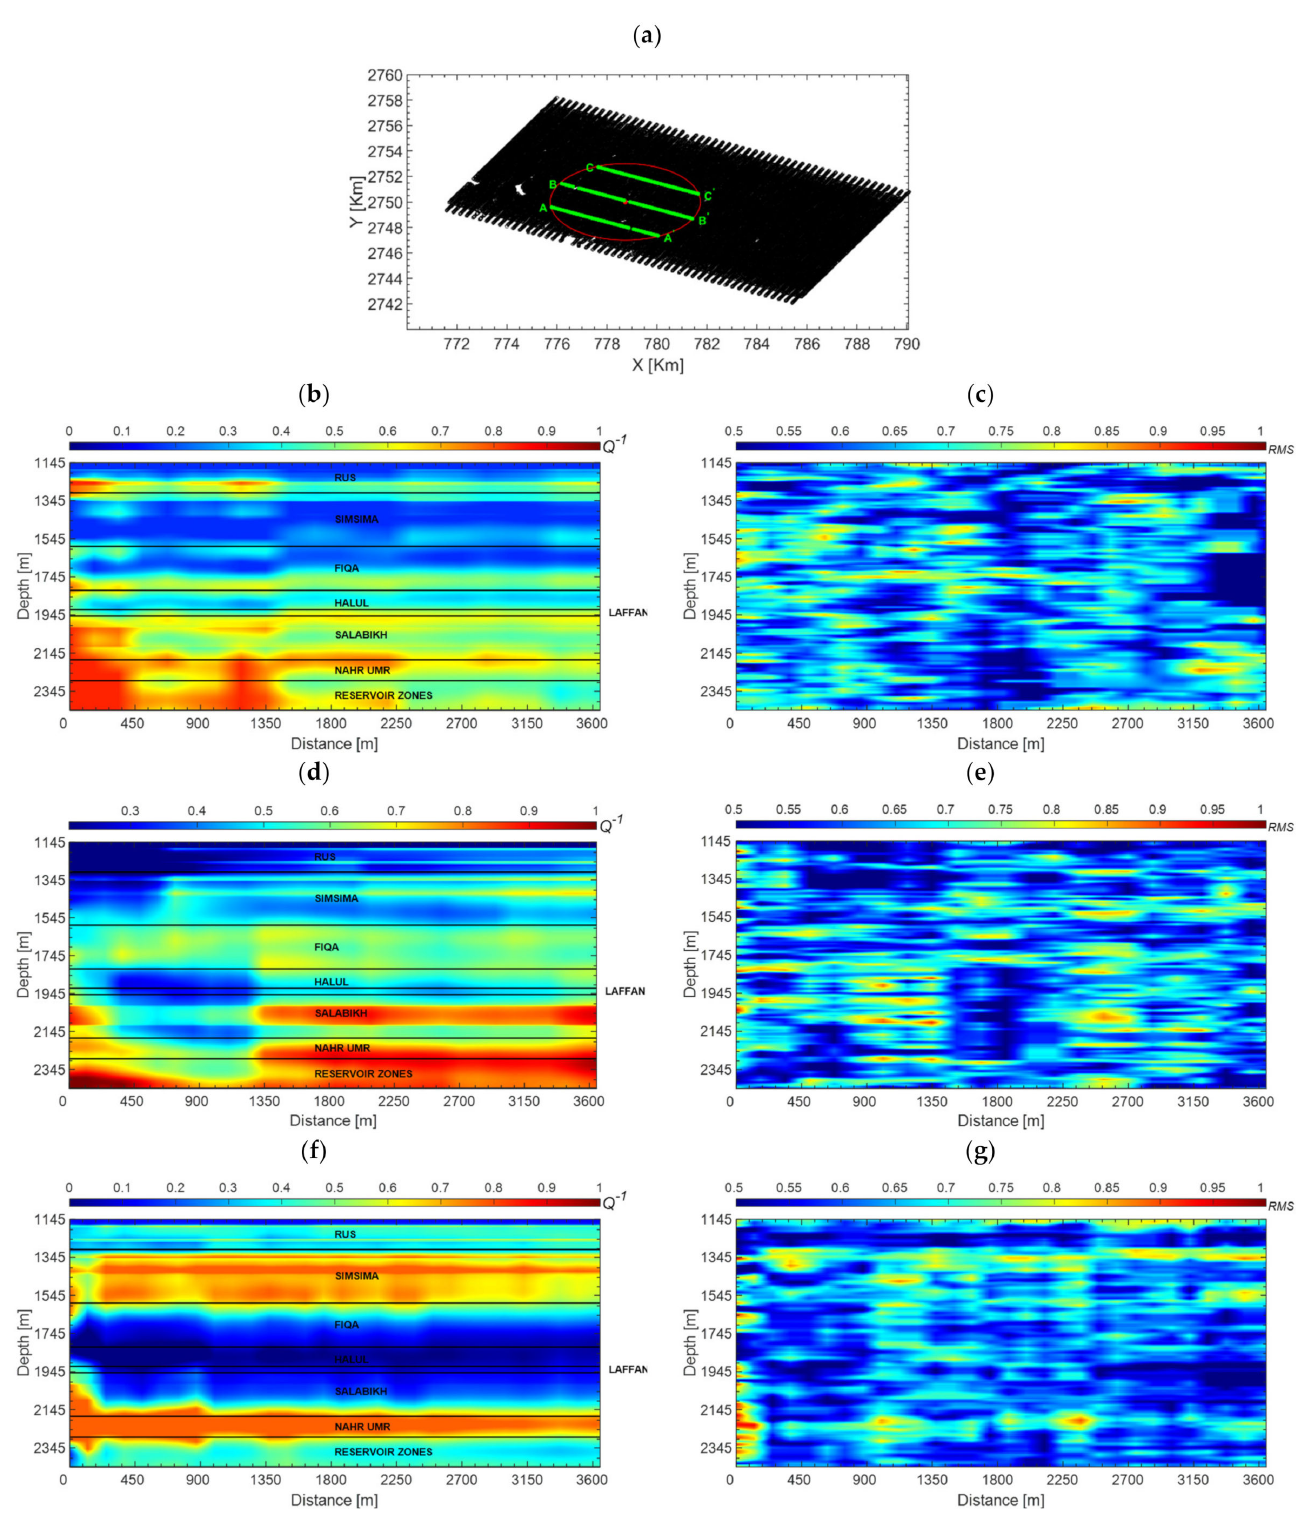
Figure 12. ( a ) Location of the 3D OBC shots (black dots). The red circle delimits the acquisition zone of 3D VSP survey, which has a maximum offset of 3000 m from the wellhead (red dot). The green lines show location of the 2D normalized and smoothed attenuation profiles estimated from hydrophone data displayed in ( b , d , f ) and R-squared of the linear regression displayed in ( c , e , g ). The solid horizontal lines and the text labels indicate the tops and names of the various geological formations